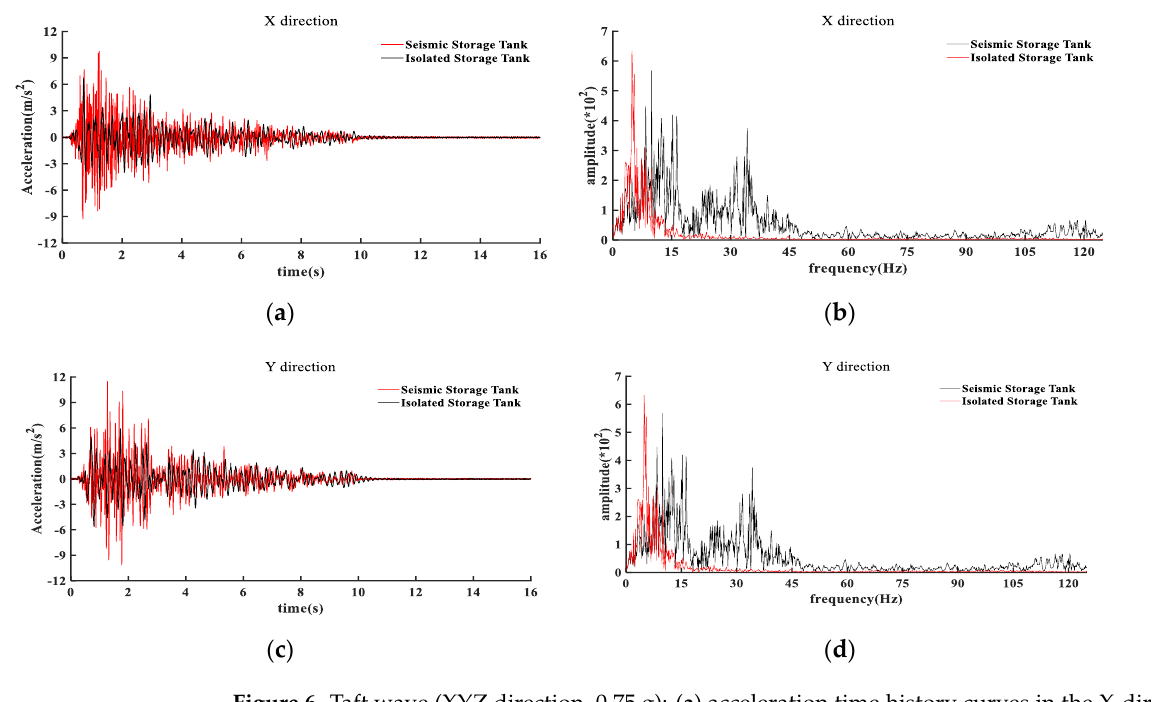
Figure 6. Taft wave (XYZ direction, 0.75 g): ( a ) acceleration time history curves in the X-direction; ( b ) spectrum characteristic curve in the X-direction; ( c ) acceleration time history curves in the Y- direction; ( d ) spectrum characteristic curve in the Y-direction.